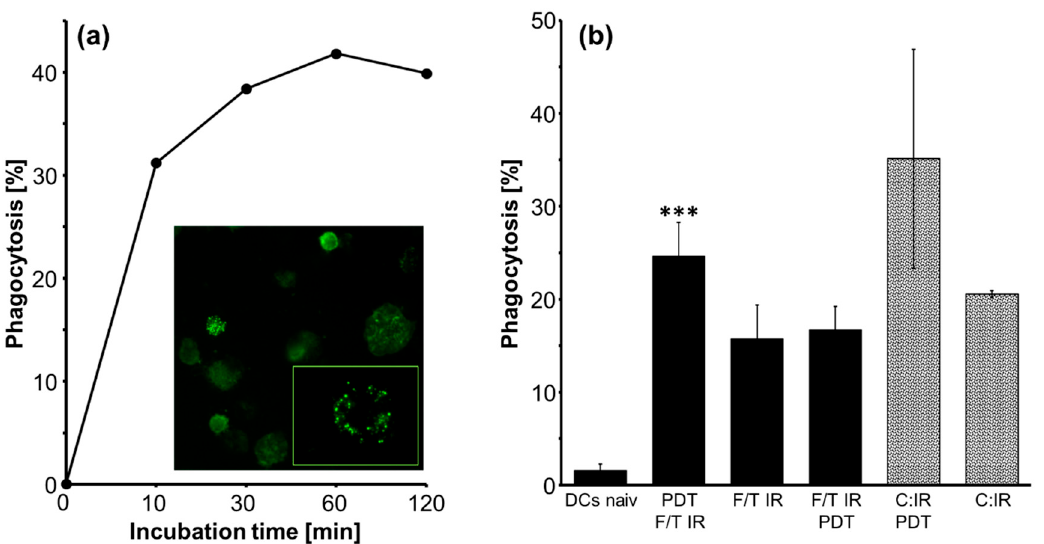
Figure 3. Phagocytosis. Quantification of phagocytic active (CFSE-positive) DCs/total number of DCs (100%). ( a ) Time-dependent phagocytosis of DCs shown in one representative experiment of two. CFDA-positive vesicles (green) prove uptake of lysate by DCs, image, original magnification: 40×, insert: 100×; ( b ) Quantification of phagocytic active (CFSE-positive) DCs/total number of DCs, mean ± SEM, n = 4; ***, p ≤ 0.001 compared to F/T IR.